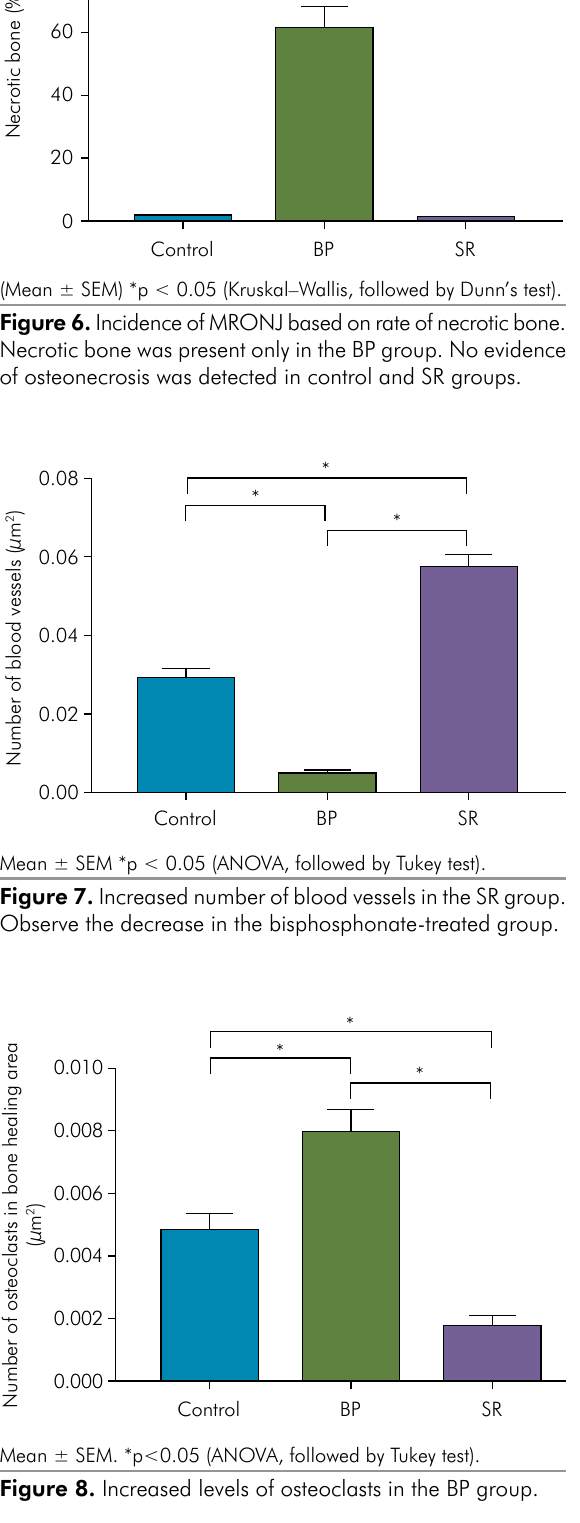
7 Braz. Oral Res.